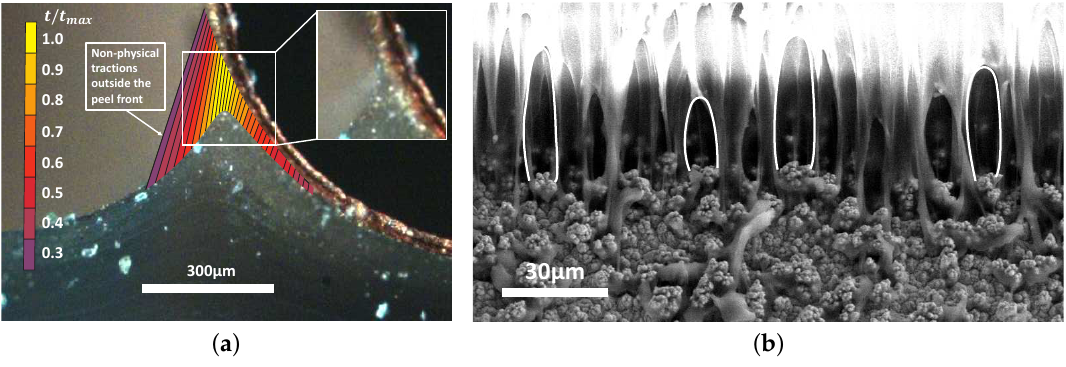
Figure 2. ( a ) illustration of the presence of non-physical tractions in regions where there is no material (left side of the PDMS lift-off geometry) caused by the macroscopic CZ model; ( b ) the copper surface roughness causes PDMS interlocking in the roughness valleys and initiation of fibrillation at the roughness